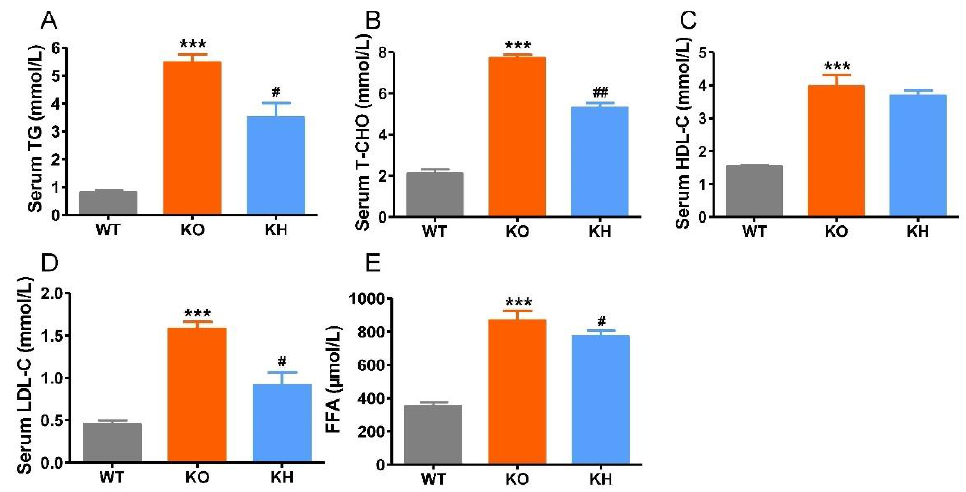
Figure 2. The serum lipid panel of each group of rats. ( A ) Total cholesterol; ( B ) triglyceride; ( C ) high-density lipoprotein cholesterol; ( D ) low-density lipoprotein cholesterol; ( E ) free fatty acids. *** p < 0.001 versus WT group; # p < 0.05, ## p < 0.01 versus KO group ( n = 5, means ± SEM).